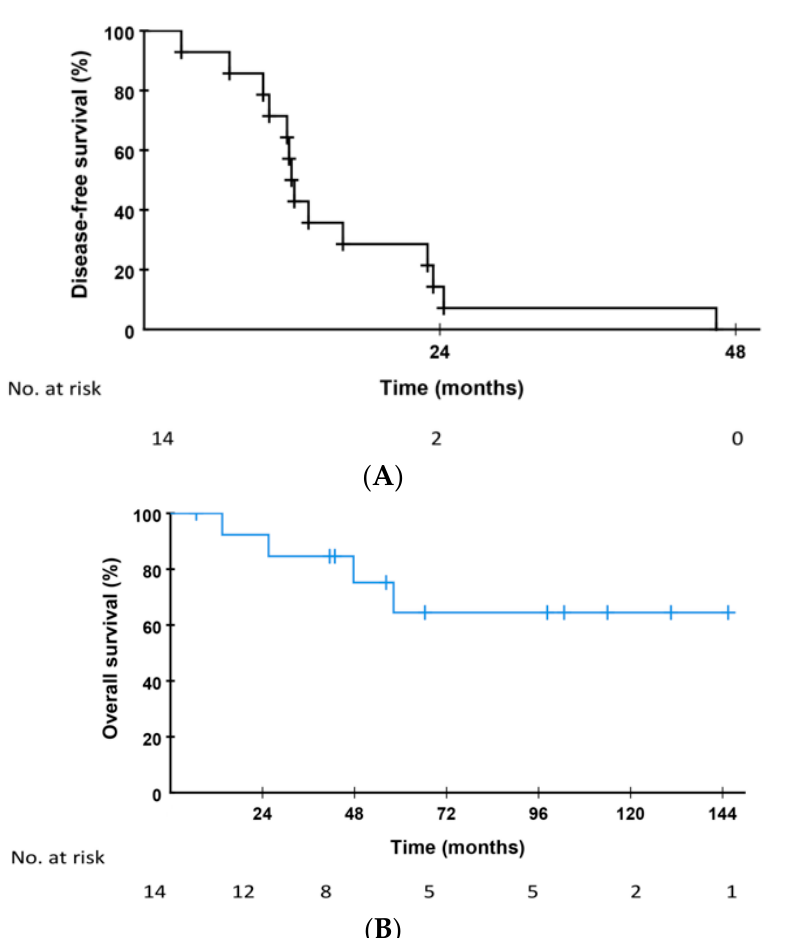
Figure 1. ( A ) Disease-free survival from time of liver transplantation (LT) in the 14 patients who had lung metastases as first site of relapse after LT and received resection of the pulmonary lesion (s) as first treatment. ( B ) Overall survival from time of pulmonary resections in the 14 patients who had lung metastases as first site of relapse after LT and received resection of the pulmonary lesion (s) as first treatment.